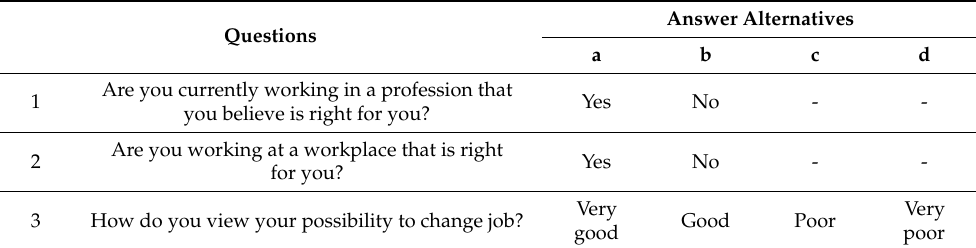
Table 1. Questions to survey the exposure job